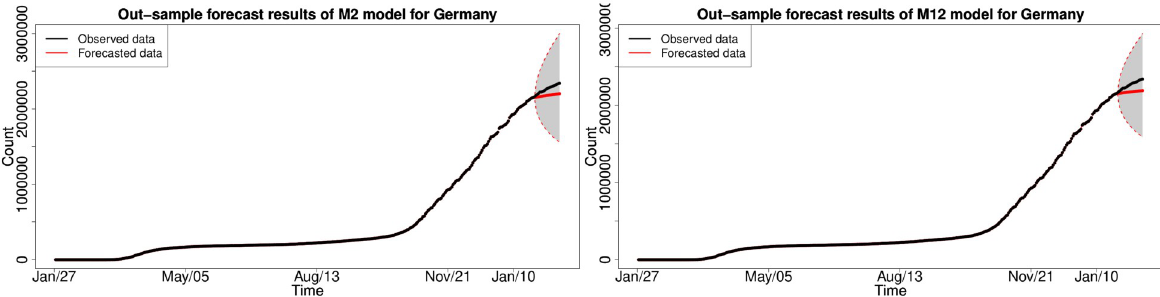
Fig 16. Out-of-sample forecast results for Germany. Out-of-sample forecast plot for Germany by Model 2 (left) and Model 12 (right).